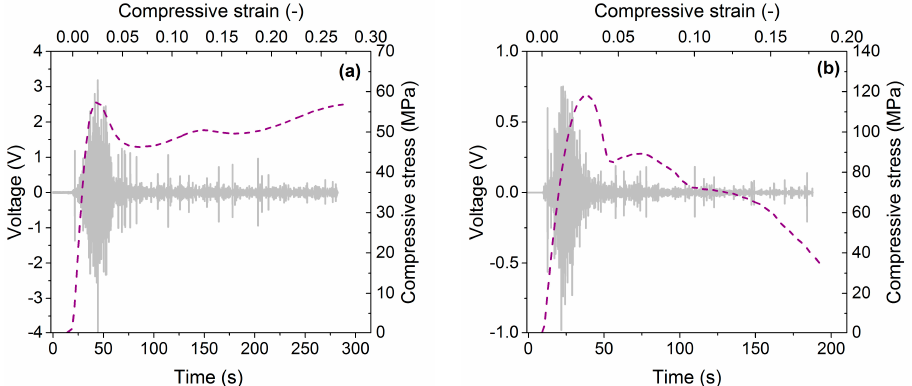
Figure 1. Typical compressive stress-strain curves (dashed line) and acoustic emission (AE) signals (grey line) for metal matrix syntactic (MMS) foams with ( a ) Al matrix; ( b ) AlSi12 matrix.